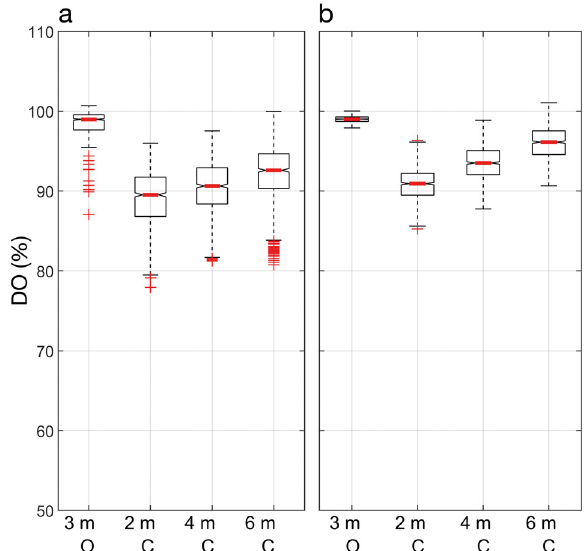
Fig. 5. Boxplot of oxygen levels at Soløya, showing com- bined oxygen data collected between (a) 21 May 17:00 h and 22 May 08:00 h and (b) 23 May 17:00 h and 24 May 08:00 h (right). The boxplots show the median DO (red line inside box), the lower edge of the box represents the 1st quartile (Q1) and the upper edge the 3rd quartile (Q3). The whiskers extends to Q1 minus 1.5 times the interquartile range (IQR) and to Q3 + 1.5 IQR. Data outside of the whiskers are measurements that exceed these limits (red crosses). The depth of the sensors is given on the x -axis with the positions. O: outside; C: centre of the